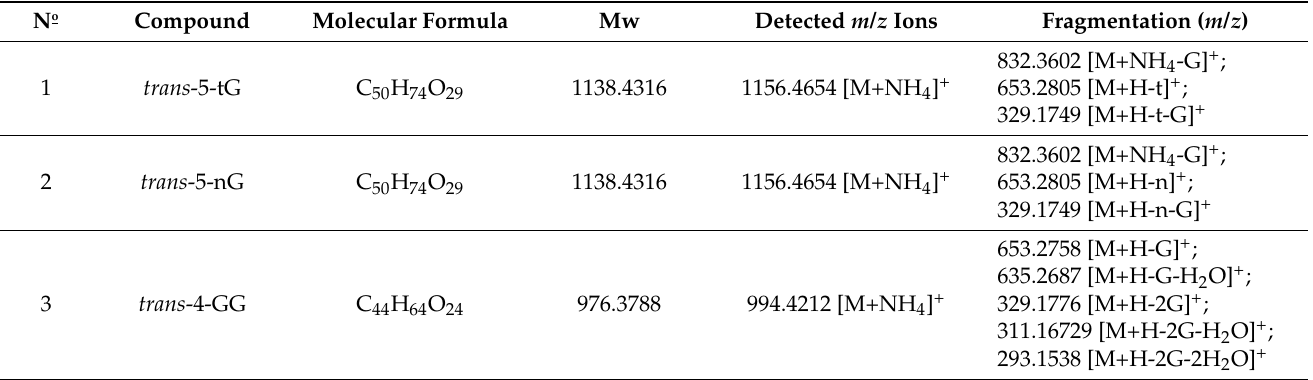
Table 1. Crocin (Crocetin ester) and crocetin isomers identified in commercial saffron extract affron ® by HPLC-Q ToF MS and HPLC-DAD-Q